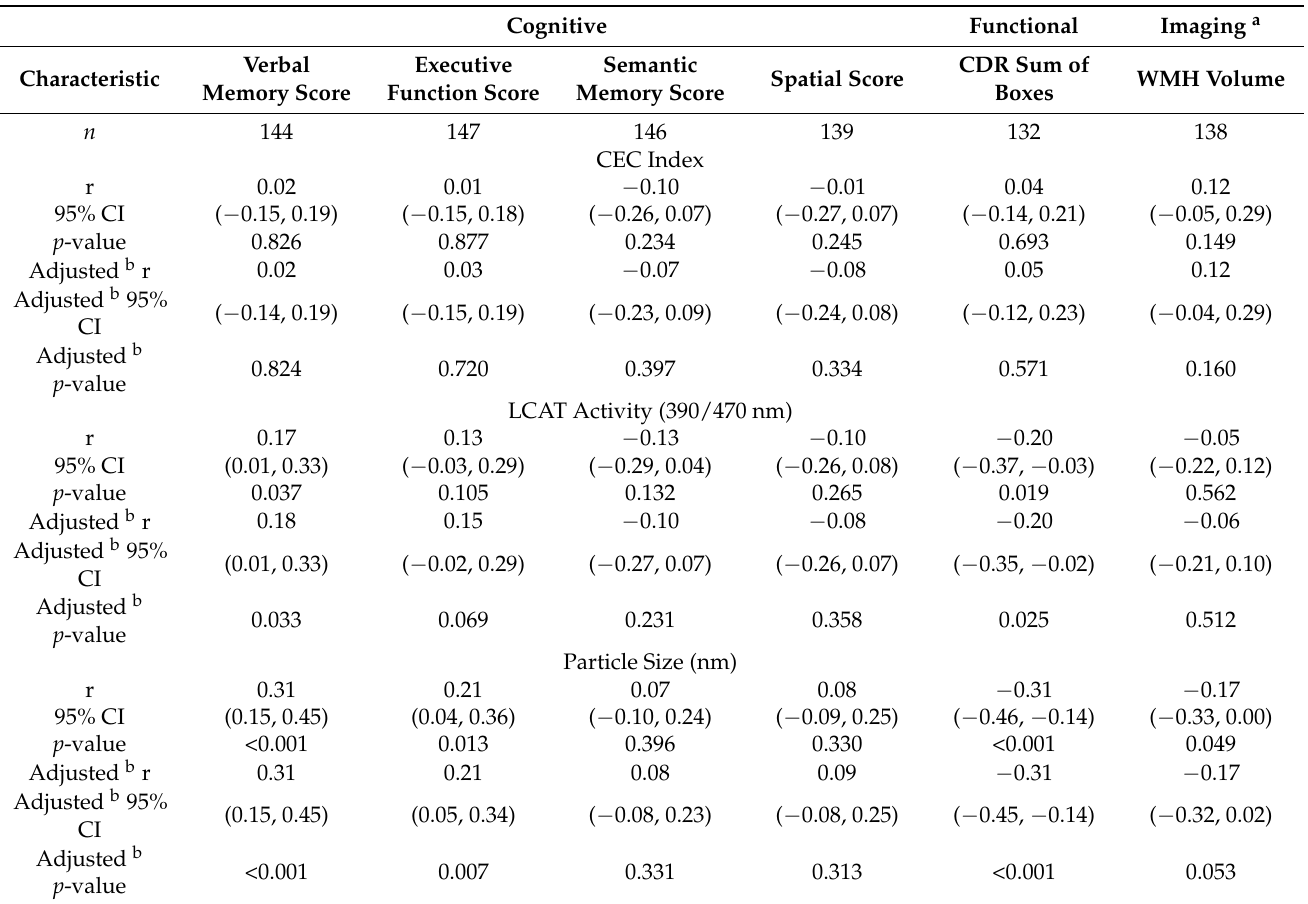
Table 4. Correlation analysis across diagnoses adjusting for APOE genotype between HDL function and size with either cognitive, functional, and magnetic resonance imaging scores. Cognitive